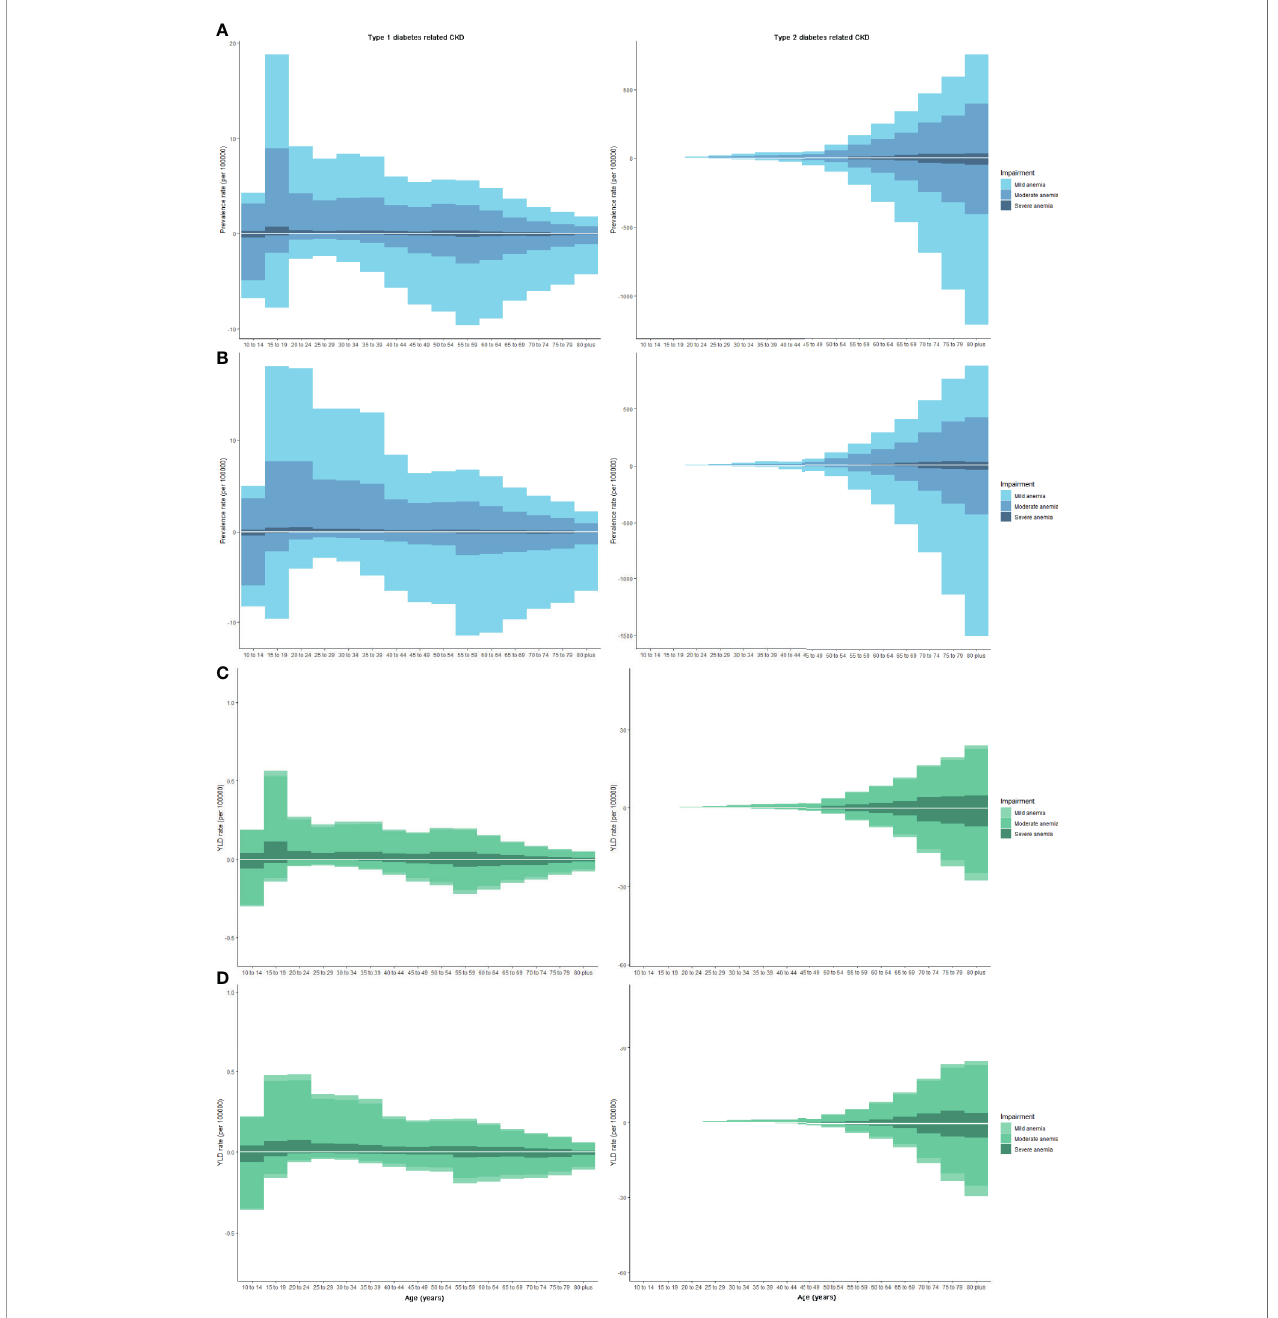
FIGURE 5 | The prevalence and YLD rate of CKD-DM-related anemia at various age subgroups by gender. Each column represents the prevalence or YLD rate (per 100,000 people) of CKD-DM-related anemia (Three grades: mild, moderate, and severe). The upper column in each age-group is data for females, and the below column is for males. (A) Prevalence in 1990; (B) Prevalence in 2019; (C) YLD rate in 1990; (D) YLD rate in 2019. CKD, chronic kidney disease; YLD, years lived with